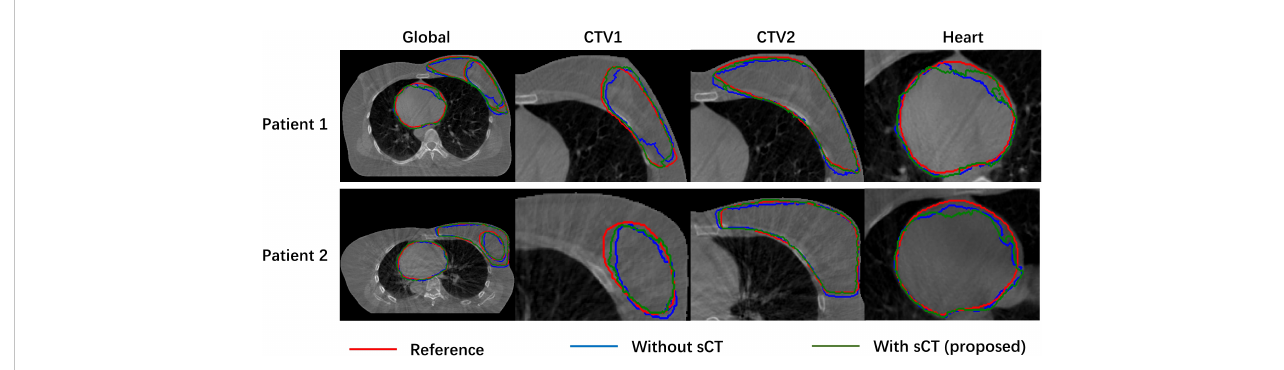
FIGURE 3 Comparison of object segmentation performance of fi xed image using CBCT image and sCT image.